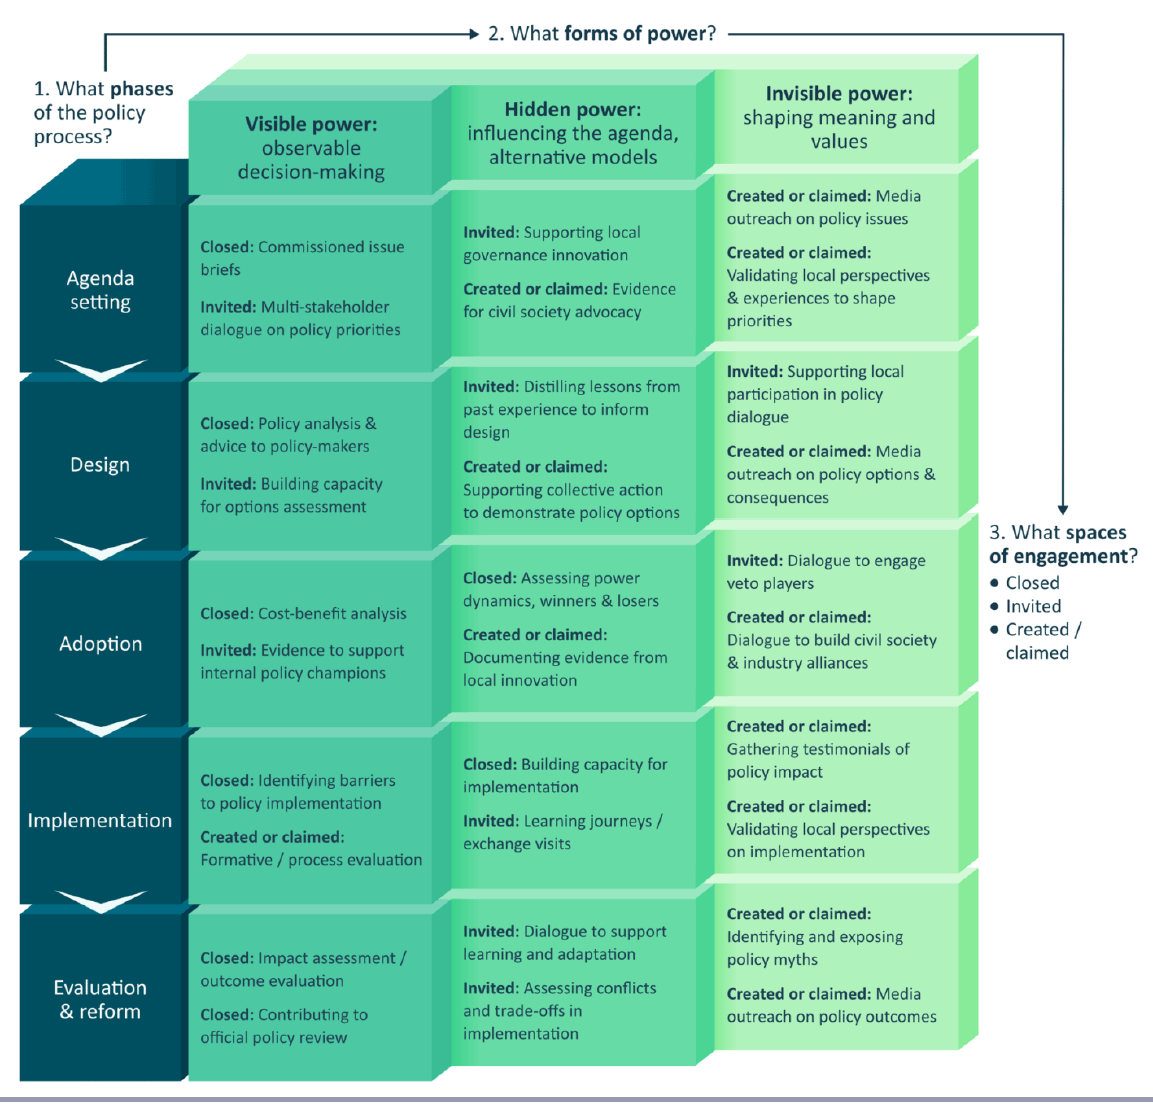
Fig. 1. A framework to assess opportunities for research engagement in the policy process. Modes of research engagement are distinguished by (1) policy phases (rows), (2) forms of power (columns), and (3) spaces of engagement (labeled within cells). Examples in the table are illustrative of possible modes of